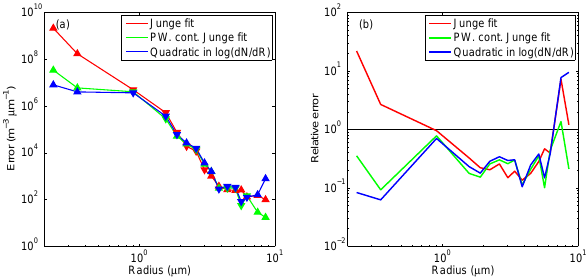
Fig. 4. Mean absolute (a) and relative (b) errors for the fits shown in Fig. 1. The relative errors are simply the absolute error normalised by the mean particle count, N . The triangles in (a) indicate whether the mean error is positive or negative.